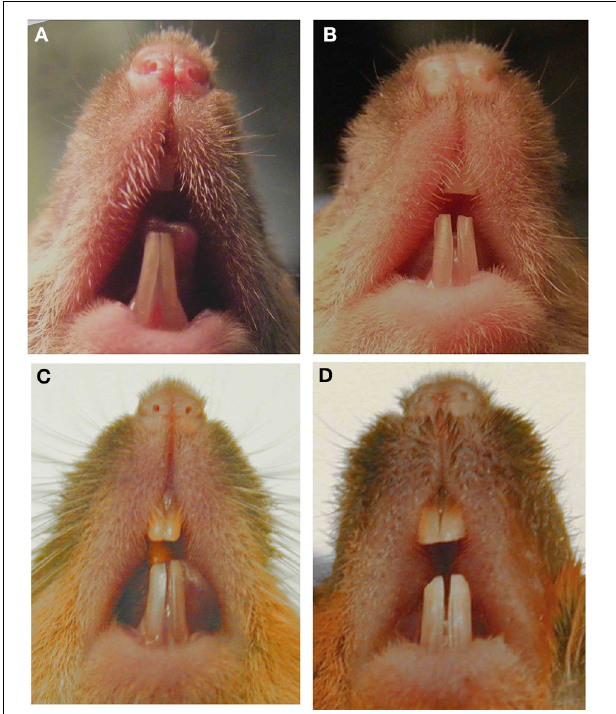
FIGURE 1 | Images of murine incisors from Amelx null mice. Null mice with mixed genetic background and phenotypic variability in (A) 7-week male, (B) 8-week male, (C) 6-month male, (D) 6-month female. This figure was originally published in Li et al.